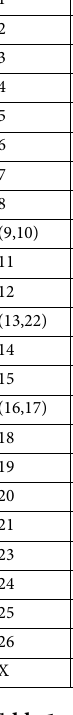
Table 1. FISH results for Oecomys auyantepui (OAU; 2n = 65 ♂ /FNa = 84), as assessed based on hybridization with Hylaeamys megacephalus (HME) whole-chromosome probes 54